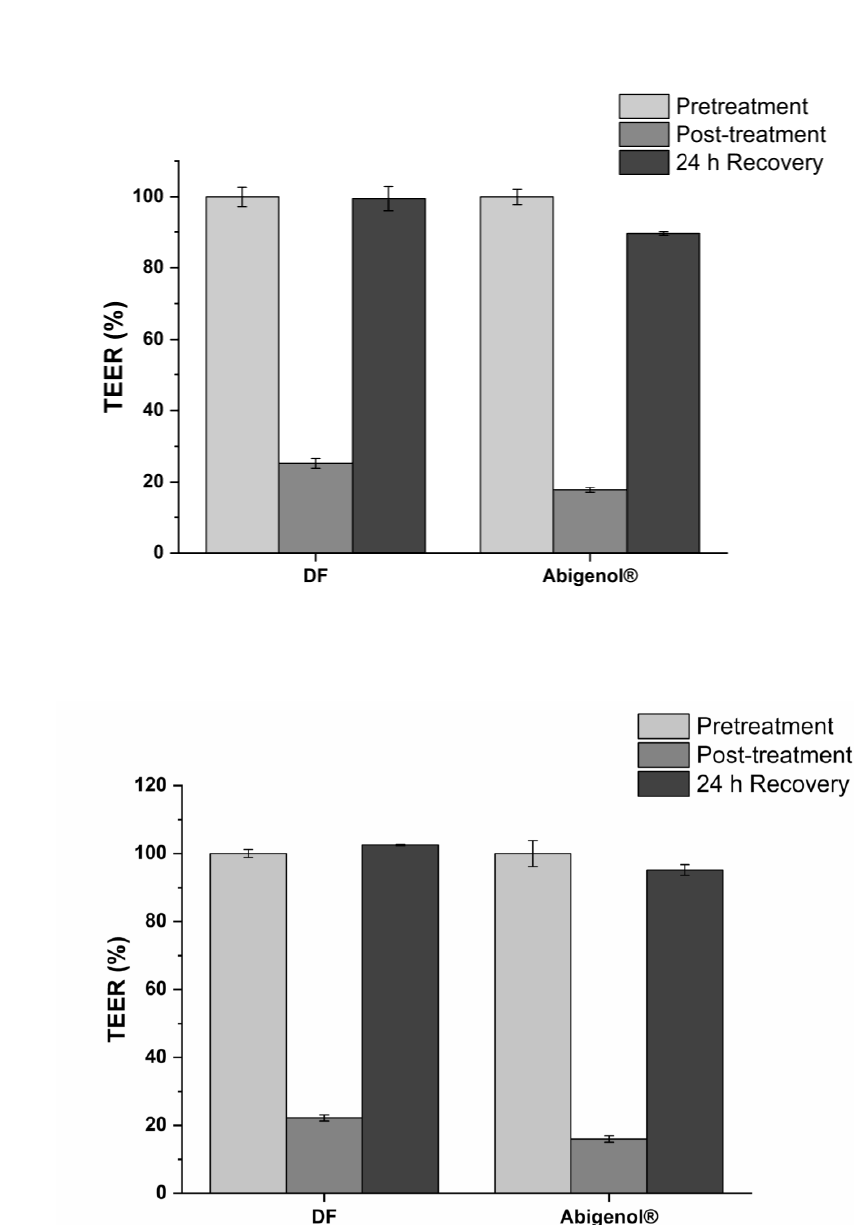
Figure 4. Cell vitality ( A ) and apparent permeability (Papp) ( B ) of intestinal epithelia exposed to digestive fluids (DF; control) and digested Abigenol ® /AlbiPhenol ® (n = 3).